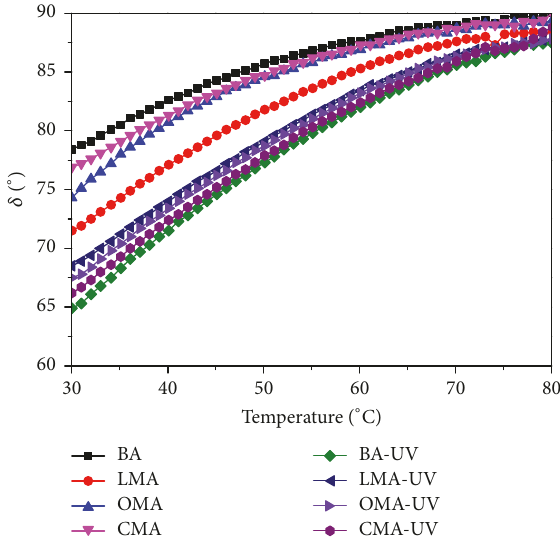
Figure 11: 𝛿 of UV aged and unaged asphalt from 30 ∘ C to 80 ∘ C.